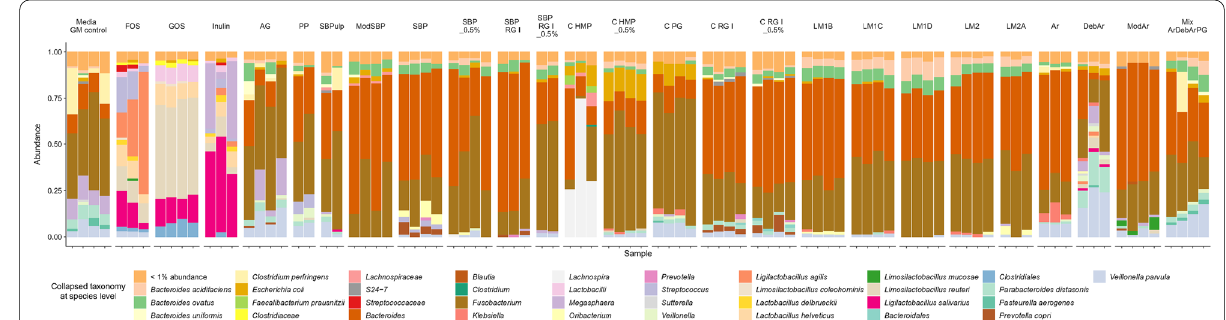
Fig. 1 Piglet gut microbiota composition (summarized on species level) as determined by 16S rRNA gene (V3-region) amplicon sequencing after in vitro simulated colon fermentation of different substrates as indicated. Only taxa with average relative abundance > 1% shown. All fermentations were carried out in quadruplicate unless otherwise stated. The additive dose is 1% except for groups with specific description of using 0.5% additive dose. Media-GM control, no added pectin saccharides, FOS fructooligosaccharides derived from chicory (n derived from milk, Inulin inulin derived from chicory (n ModSBP modified sugar beet pectin, SBP sugar beet pectin, SBP_0.5% same, but 0.5% substrate; SBP_RG-I (n beet pectin derived rhamnogalacturonan I, C-HMP and C-HMP_0.5, citrus derived high methoxyl pectin (n